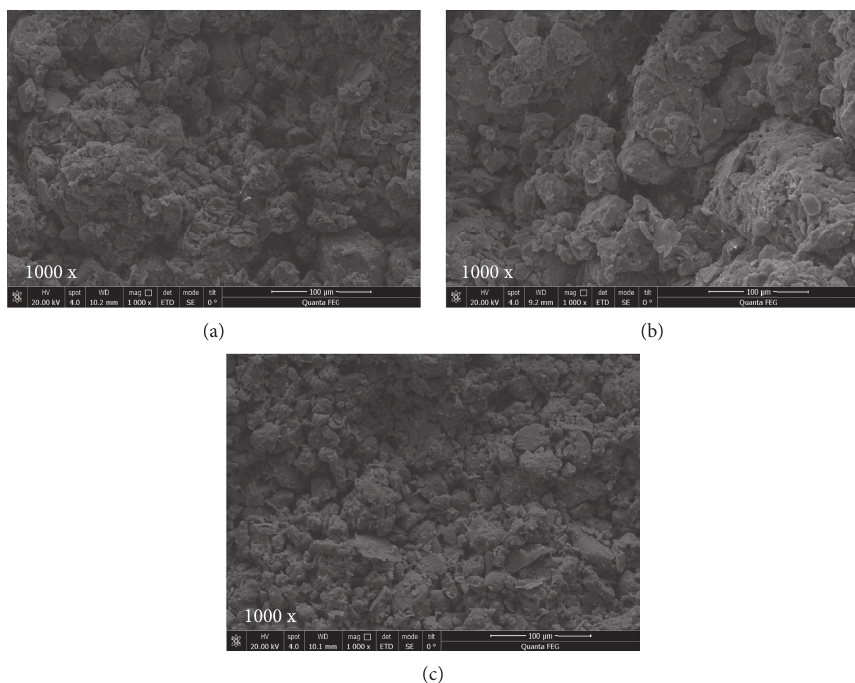
Figure 5: Micrographs of (a) intact, (b) compacted, and (c) saturated loess.